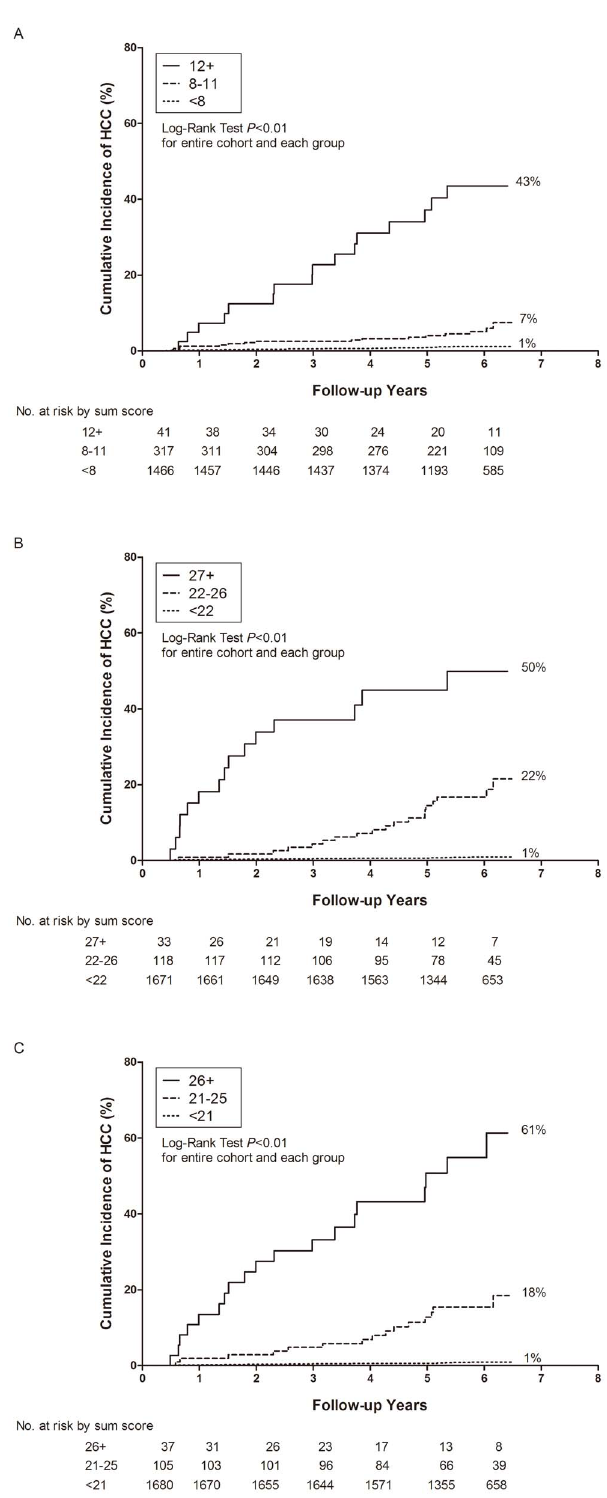
Figure 3. Cumulative incidence of hepatocellular carcinoma (HCC) by sum scores of each model at study entry. Classical model (Risk Model I, A), the model combining liver-related seromarkers without HBV seromarkers of HBeAg serostatus and serum HBV DNA level (Risk Model II, B), and the model combining liver-related seromarkers with HBV seromarkers (Risk Model III, C).